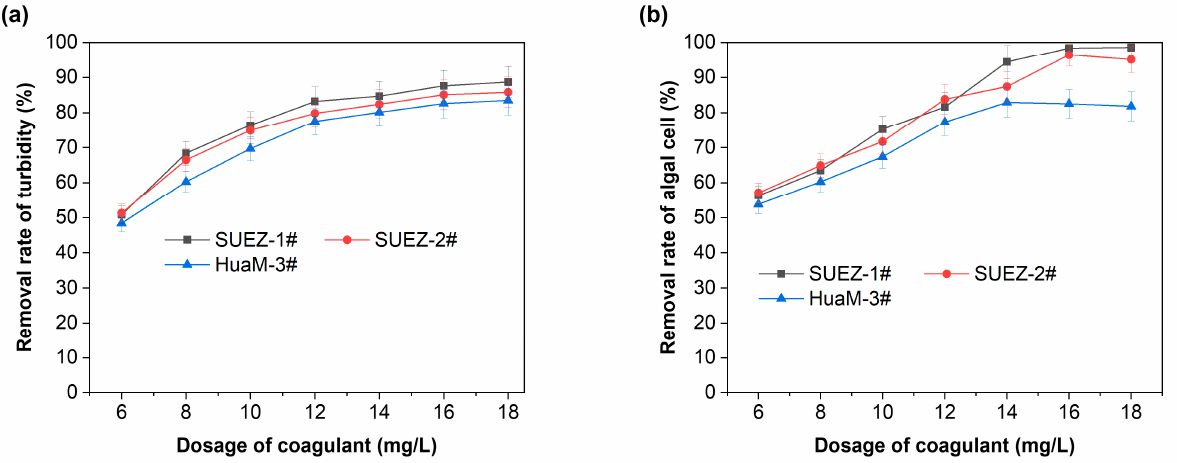
Figure 5. Impact of the dissolved air release head on the turbidity removal rates ( a ) and algal cell removal rates ( b ).